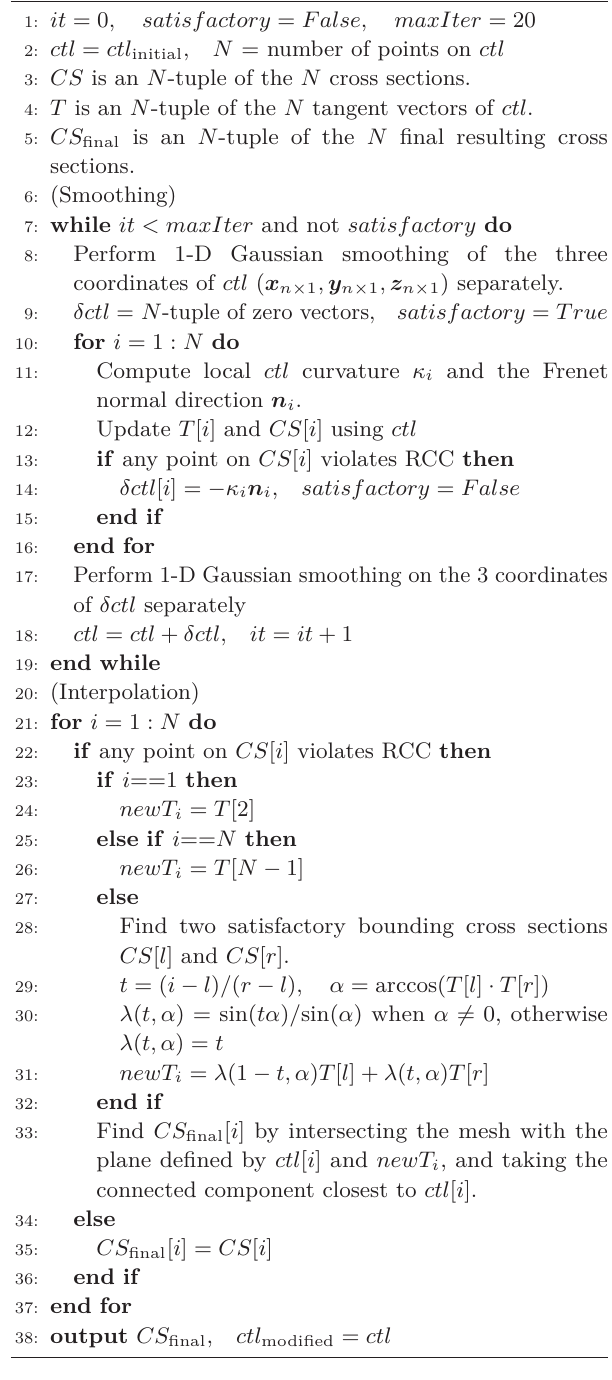
Algorithm 1 Centerline modification